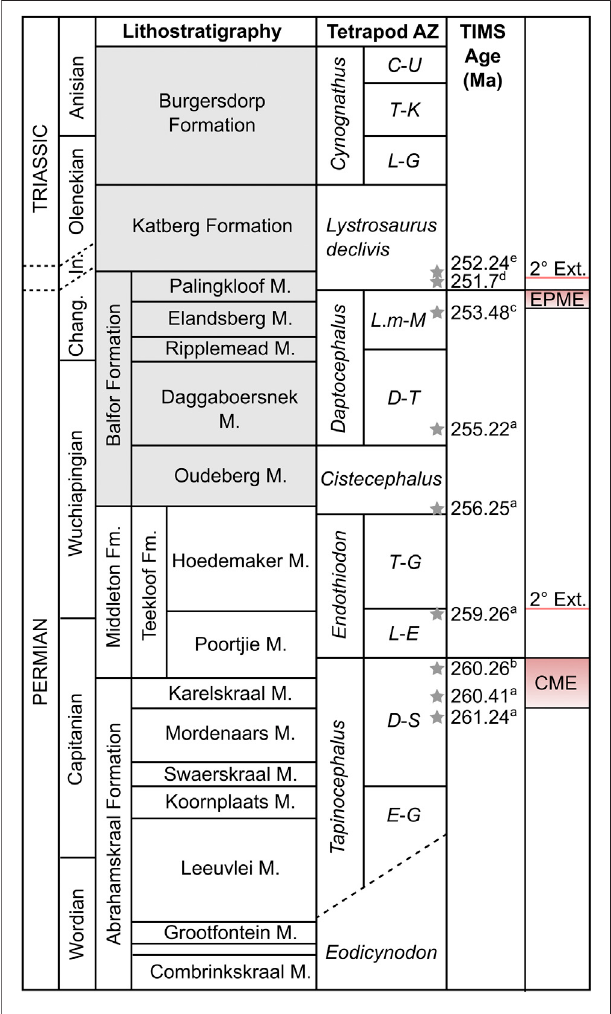
FIGURE 1 | Stratigraphy of the Beaufort Group showing position of mass extinction intervals. Subzone abbreviations: C-U , Cricodon- Ufudocyclops ; D-S , Diictodon-Styracocephalus ; D-T , Dicynodon- Theriognathus ; E-G , Eosimops-Glanosuchus ; L-E , Lycosuchus- Eunotosaurus ; L-G , Langbergia-Garjainia ; L.m-M , Lystrosaurus maccaigi- Moschorhinus ; T-G , Tropidostoma-Gorgonops ; T-K , Trirachodon- Kannemeyeria . Other abbreviations: CME, Capitanian mass extinction; Changh,Changhsingian;Fm.,Formation;In,Induan;M,member;EPME,end- Permian mass extinction. Lithostratigraphic units in grey found only in the Eastern Cape. Stratigraphy and biozonation modi fi ed after Smith et al. (2020) and position of end-Permian mass extinction after Botha et al. (2020). U-Pb ages after: a, Rubidge et al., 2013; b, Day et al., 2015a; c, Gastaldo et al., 2015; d, Botha et al., 2020; e, Gastaldo et al., 2020. Actual position of the Permo-Triassic boundary is